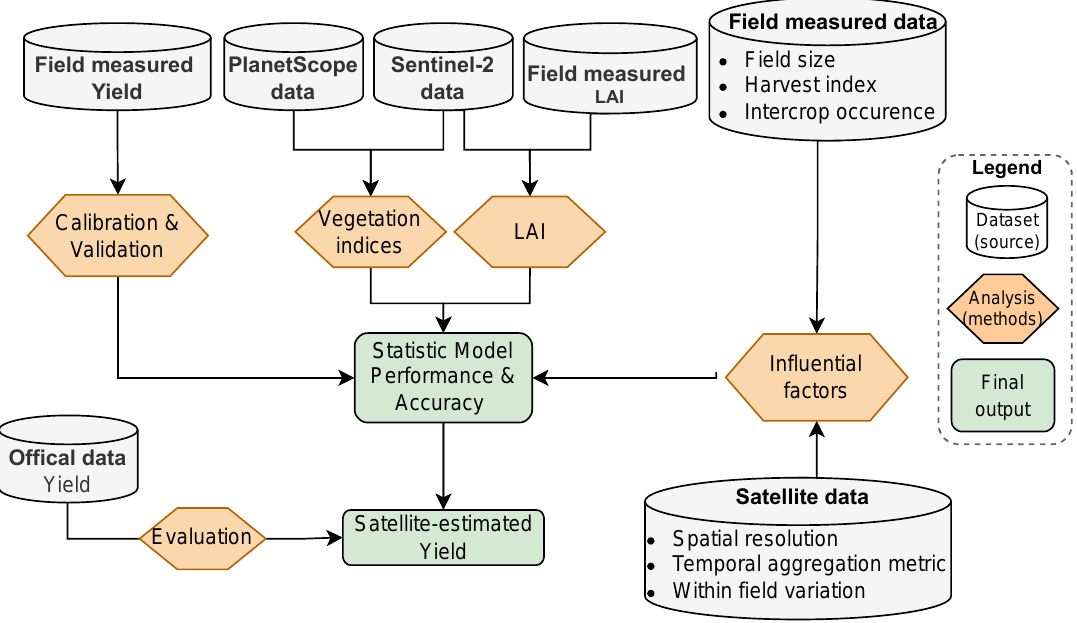
Figure 3. Flowchart showing the approach used to estimate crop yield and evaluate factors influencing model accuracy.